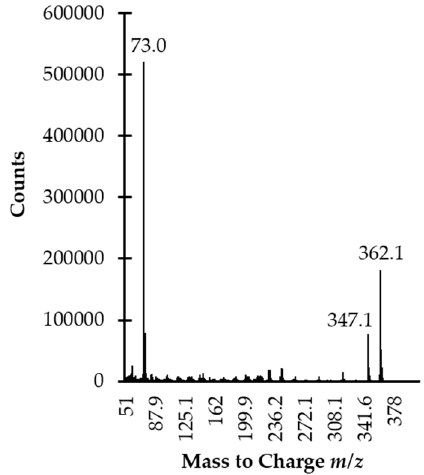
Figure 3. Electron ionization scan mode mass spectra of the HPPTCA-TMS derivative obtained by analyzing standard solution of HPPTCA (100 µmol L − 1 ) prepared according to the procedure described in Section 3.6.